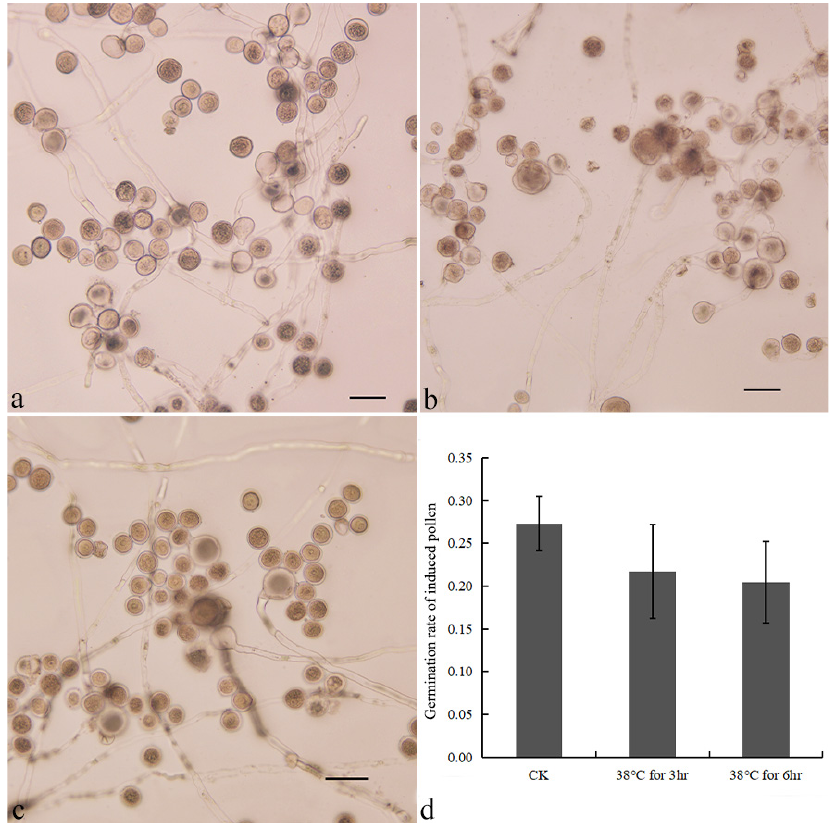
Figure 3. Effect of high temperature on pollen viability in P. canescens. ( a ) Germinated fresh pollen grains derived from the control group. ( b ) Germinated pollen grains derived from the treatment at 38 ◦ C for 3 h. ( c ) Germinated pollen grains derived from the treatment at 38 ◦ C for 6 h. ( d ) Pollen viability in flower buds exposed to 38 ◦ C for 3 or 6 h in P. canescens . Control corresponds to 25 ◦ C, that is, standard culture conditions. Bars = 50 µ